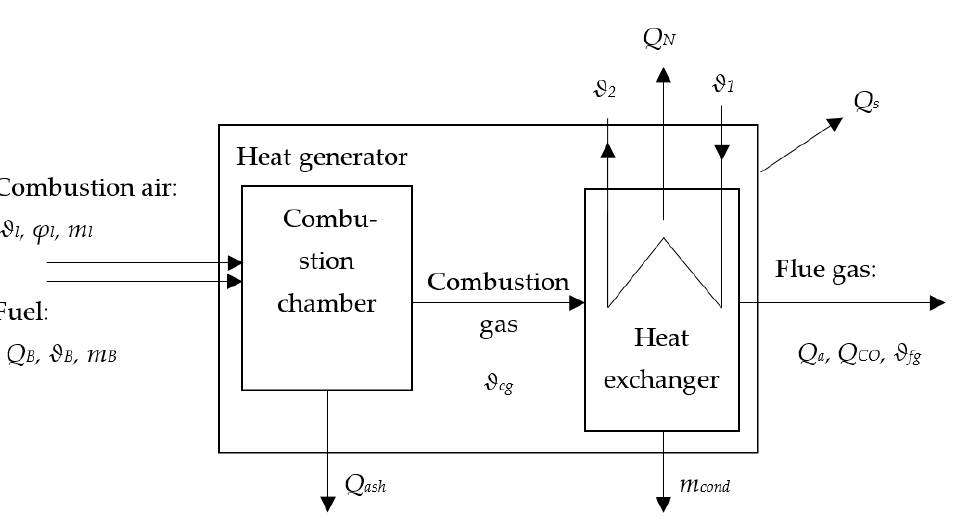
Figure 2. System definition for boiler process.